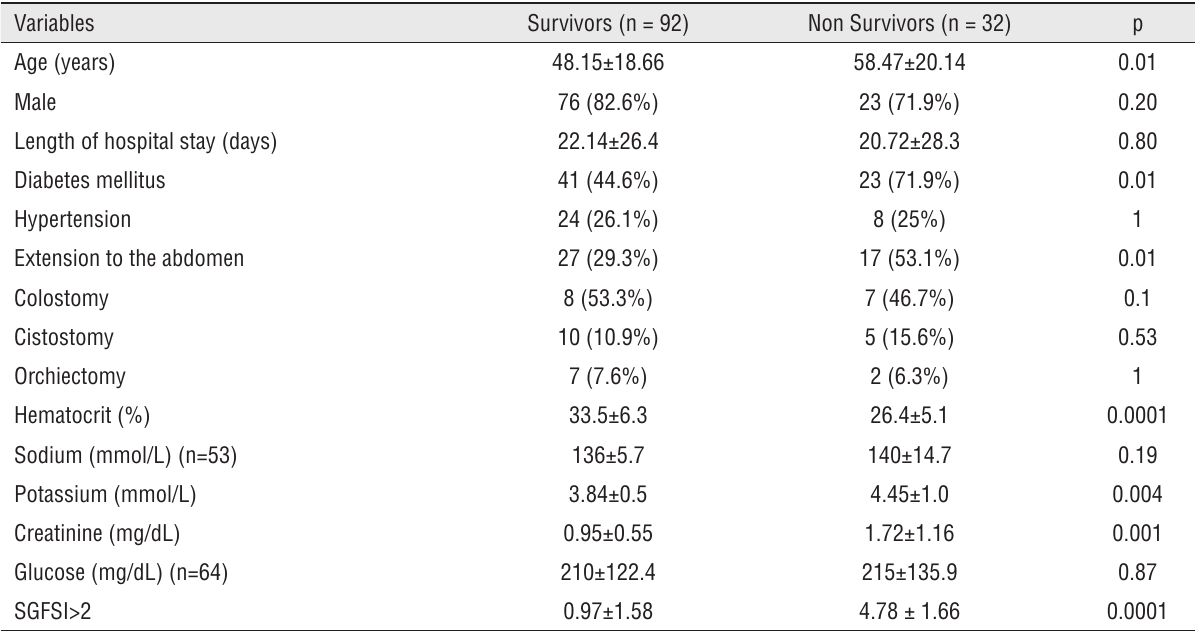
Table 2 - Distribution of variables according to